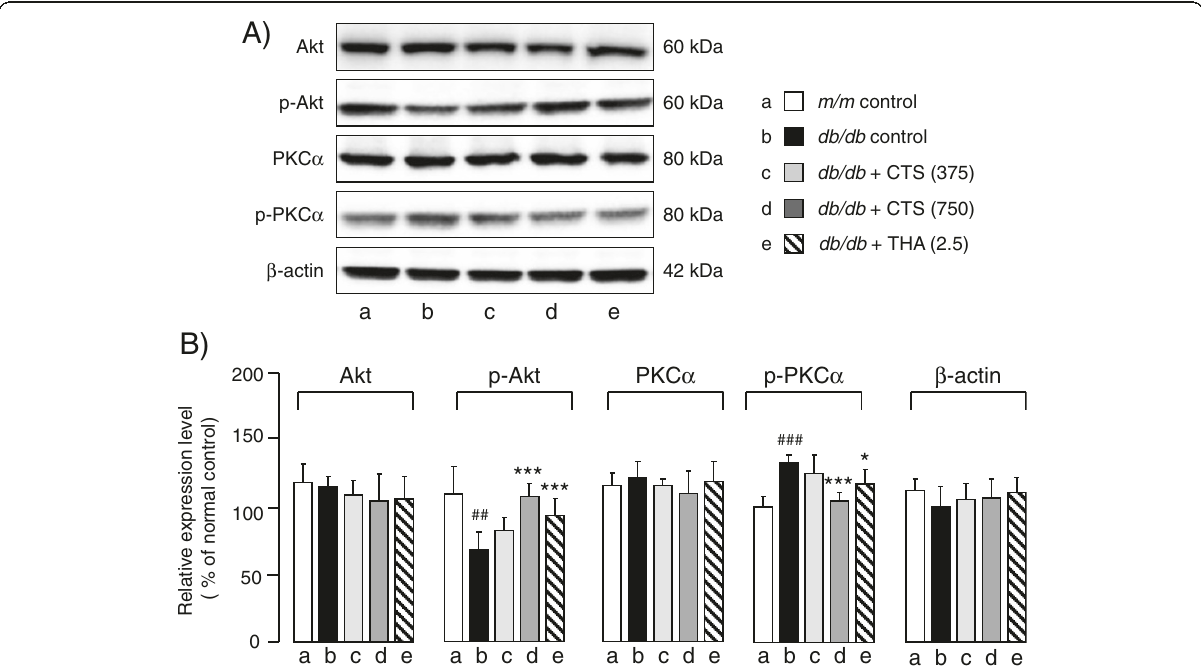
Figure 6 Effects of CTS and THA treatment on Akt, p-Akt, PKC α , p-PKC α / β II, and β -actin in the hippocampi of db/db mice. After completing the behavioral studies, the animals were decapitated and proteins were extracted from the hippocampi in each animal group. A ) Typical photos indicating the expression levels of each factor in the hippocampus of vehicle-treated m/m (lane a), and vehicle (lane b)-, CTS (325 mg/kg per day: lane c; 750 mg/kg per day: lane d)-, and THA (2.5 mg/kg per day; lane e)-treated db/db mice. B ) Quantitative comparisons of test drug-induced changes in Akt, p-Akt, PKC α , p-PKC α / β II, and β -actin in the hippocampi of db/db mice. The data are expressed as the percentage of the value obtained from naïve control m/m mice. Each data column represents the mean ± S.D. obtained from 5-6 brain samples. # P < 0.05 or ## P < 0.01 vs. vehicle-treated SAMR1 group (Student ’ s t -test). ## P < 0.01, * P < 0.05, *** P < 0.001 vs. respective vehicle-treated db/db group (one-way ANOVA followed by Tukey